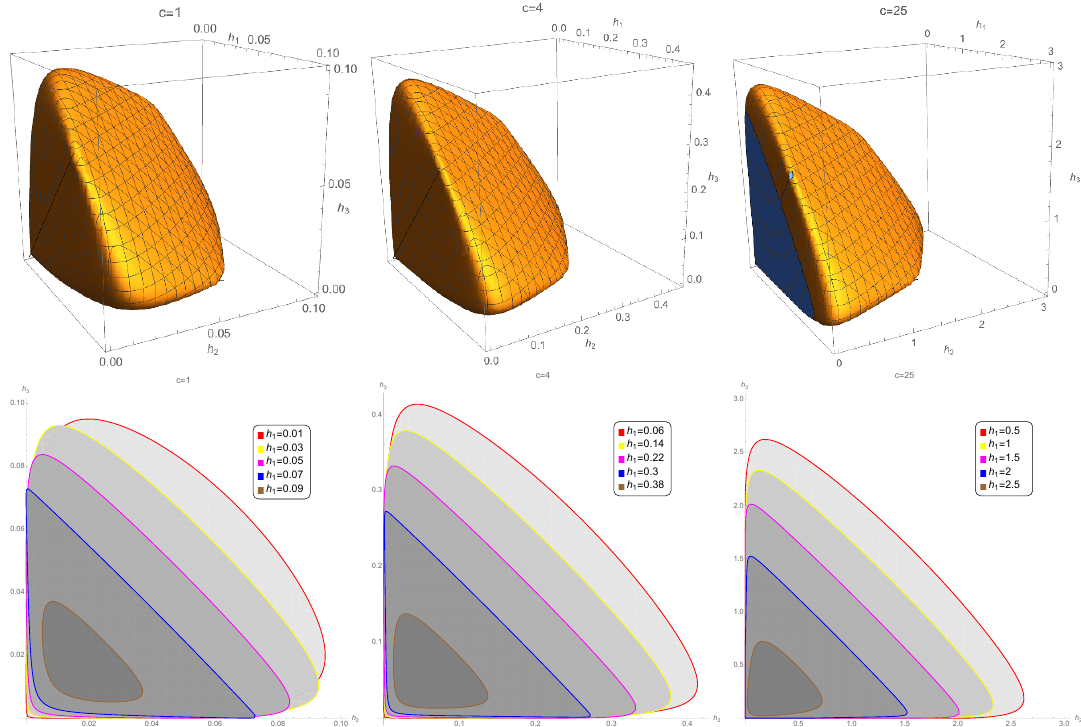
for c = 1 ; 4 ; 25. Bottom : plots of the h